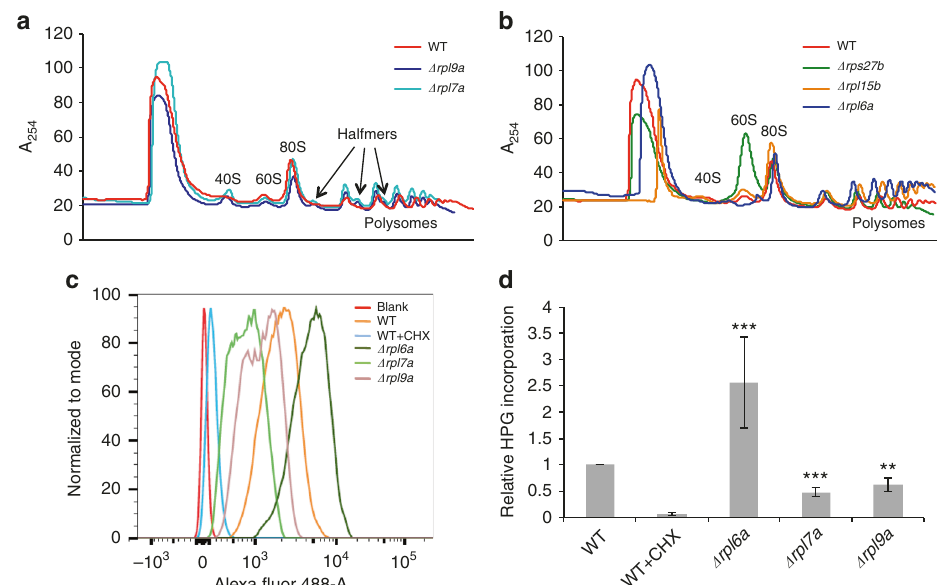
Fig. 2 Long-lived RPKO strains show defective ribosome assembly and reduced translation. a and b Polysome pro fi les of a long-lived and b short-lived RPKO strains in relation to the wild-type strain show that the former have a lower 60S-to-40S ratio, and are characterized by the presence of half-mers. c Flow cytometry readout for nascent protein synthesis by Click-iT HPG in the different strains and conditions. d Quanti fi cation of global translation in RPKOs with respect to the wild-type strain. Error bars represent s.d. across three different biological replicates. ** p < 0.01, *** p < 0.001. P -values were calculated using two-tailed Student ’ s t